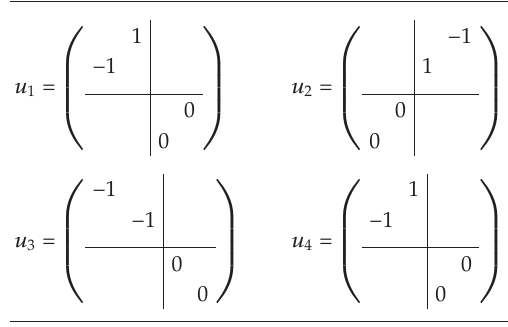
(cid:6) d T A (cid:7) u A